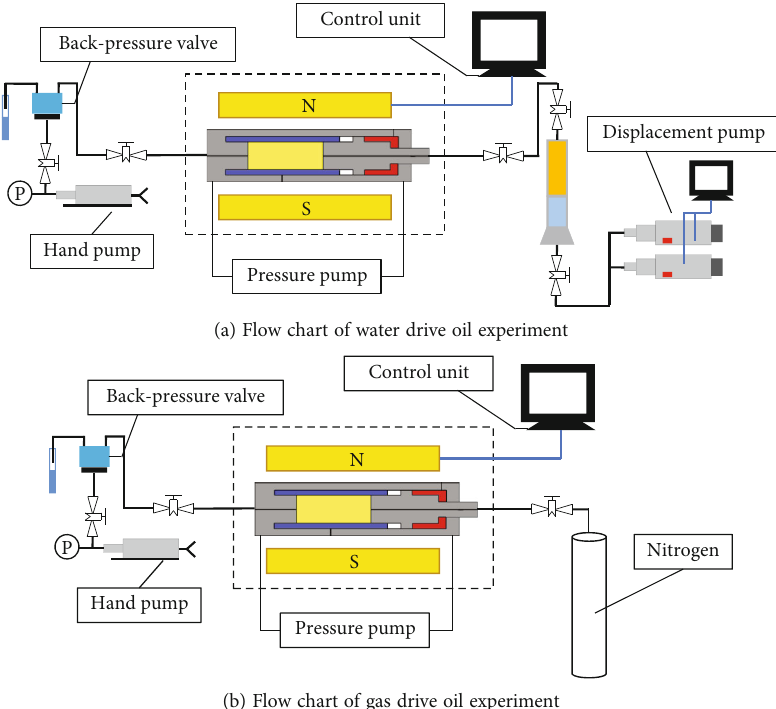
Figure 2: Flow chart of online NMR